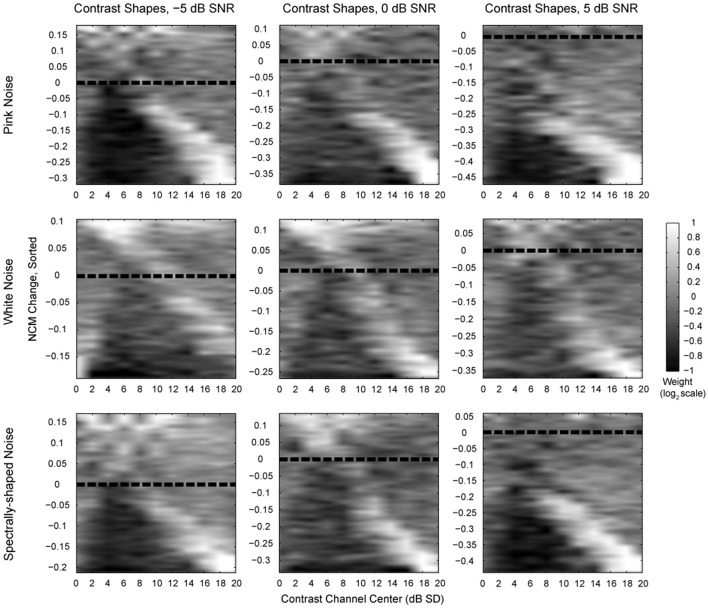
The effects of various contrast weight vector shapes on noisy speech computed intelligibility. Each panel represents a complete systematic search of the contrast weight space with different additive noise conditions and at different SNRs. The difference in NCM scores, calculated with N = 8 frequency bands, between the processed and original noisy speech for each contrast weight vector shape was used to sort the contrast shapes themselves. Each systematic search consisted of all permutations for weights of 2−1, 20, and 21 on each of the 11 contrast channels. The sorted contrast weights were then interpolated and smoothed to produce the display images. Lighter values correspond to higher weights, showing a convergence on intermediate contrast values at the best NCM scores. For pink noise, improvements achieved +0.04 (+5% relative to 0.87) at 5 dB SNR, +0.11 (+15% relative to 0.75) at 0 dB SNR and +0.18 (+30% relative to 0.6) at −5 dB SNR. For white, Gaussian noise, improvements in the NCM score achieved +0.09 (+12% relative to 0.77) at 5 dB SNR, +0.13 (+20% relative to 0.64) at 0 dB and +0.11 (+21% relative to 0.52) at −5 dB. For spectrally shaped noise, improvements achieved +0.06 (+7% relative to 0.84) at 5 dB SNR, +0.14 (+20% relative to 0.69) at 0 dB SNR and +0.17 (+33% relative to 0.51) at −5 dB SNR.